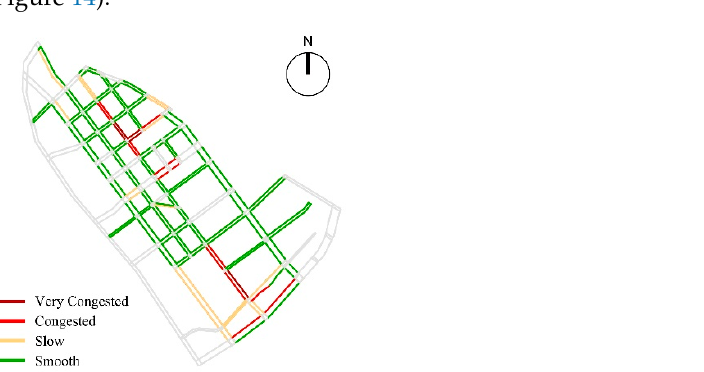
Figure 14. Comprehensive analysis of Pedestrian safety.